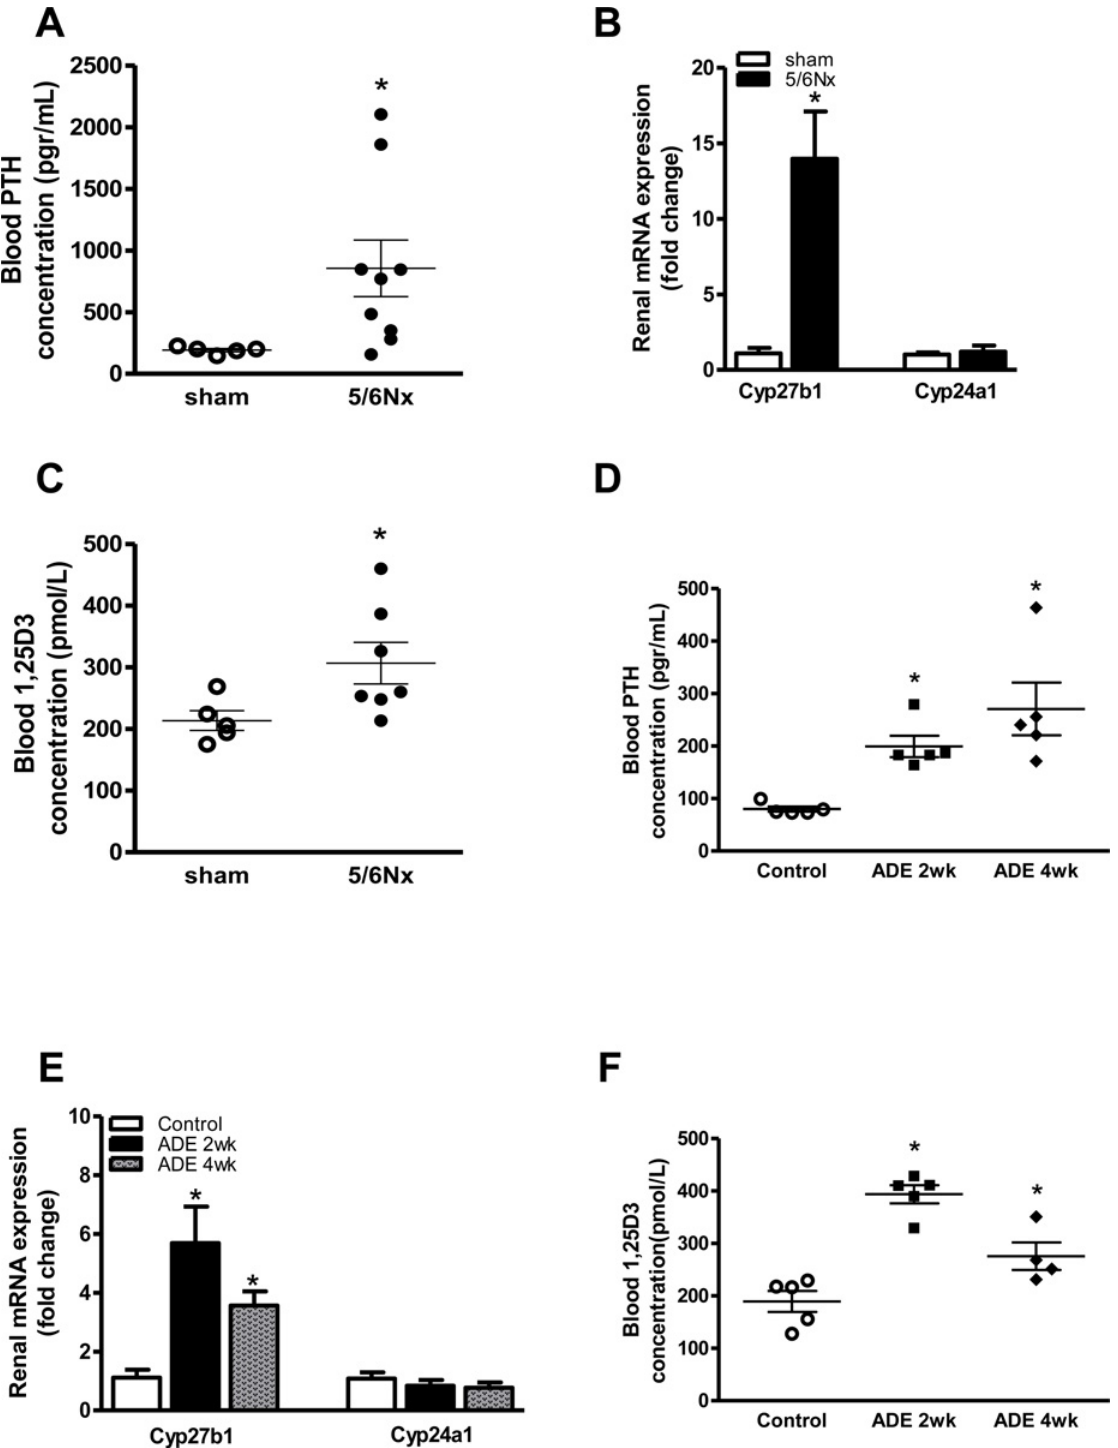
Fig 3. Experimental kidney failure augmented renal vitamin-D synthesis and induced secondary hyperparathyroidism. (A) PTH levels were elevated three weeks after 5/6Nx. (B) mRNA expression of Cyp27b1 and Cyp24a1 in 5/6Nx mice (black bars) compared with sham-operated group (white bars). (C) levels of 1,25-dihydroxy vitamin D 3 in the blood were measured in mice with 5/6Nx nephrectomy. (D) PTH levels were elevated progressively in ADE treated mice in both 2 weeks and 4 weeks ADE treated mice compared with control groups. (E) mRNA expression of Cyp27b1 and Cyp24a1 in CKD induced by 2 weeks (black bars) and 4 weeks (gray bars) ADE treated mice compared with control groups (white bars) and (F) levels of 1,25-dihydroxy vitamin D 3